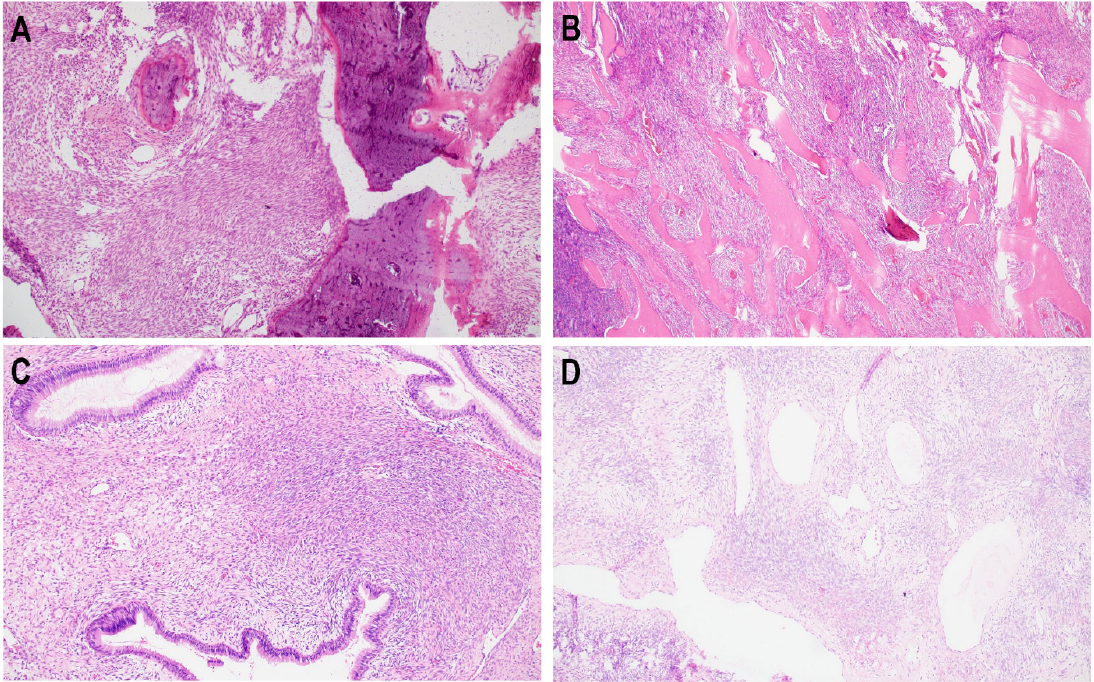
Figure 2. BSNS distinctive characteristic feature of BSNS is bone trabeculae infiltration, which was observed both, in incisional biopsy ( A ) and resection specimens ( B ). Other common findings are entrapped invaginations of hyperplastic respiratory epithelium ( C ) or stroma with “hemangiopericytoma-like” staghorn vessels ( D ).